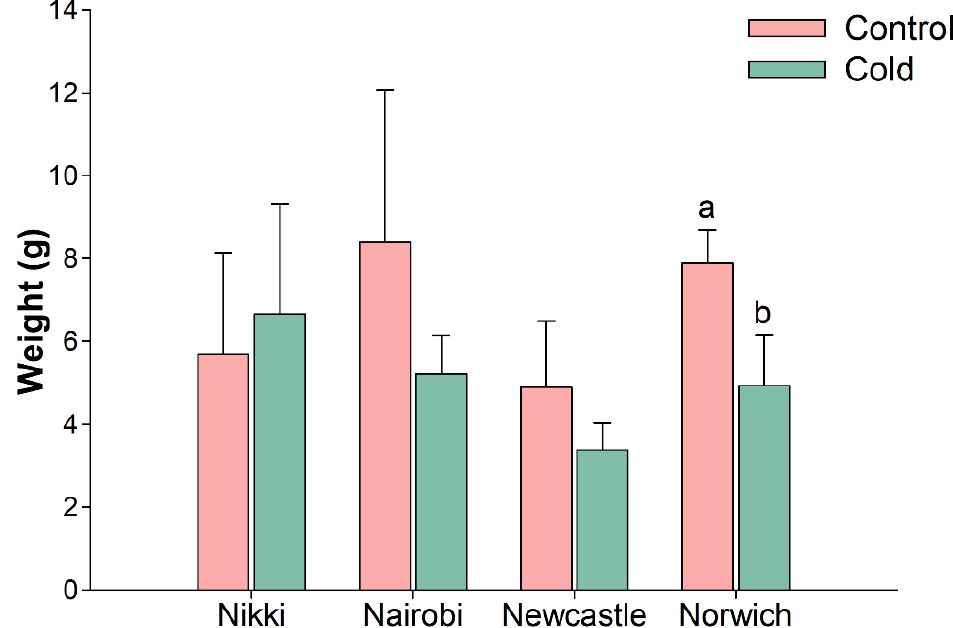
Figure 2. Root fresh weight seven days after initiation of cold challenge experiment in carrot cultivars ’Nairobi’, ‘Newcastle’, ‘Nikki’, and ‘Norwich’. Plants from control were always grown at 25 ◦ C and samples from cold treatment were grown at 5 ◦ C during seven days. Significant difference in cultivar ‘Norwich’ is indicated by different letters ( p < 0.05). Carrot plants are shown in Figure S1.